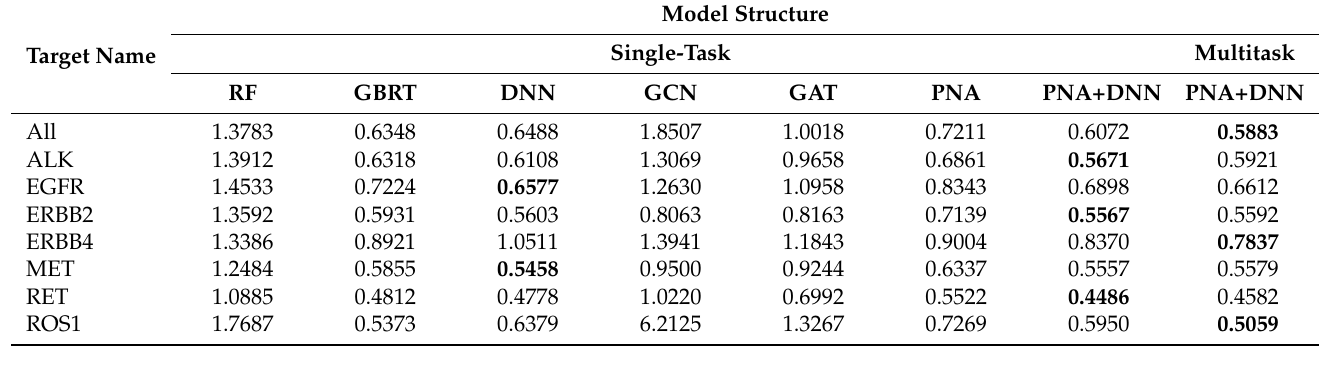
Table 1. Comparison of baseline algorithms by average RMSE over 10-fold cross-validation.